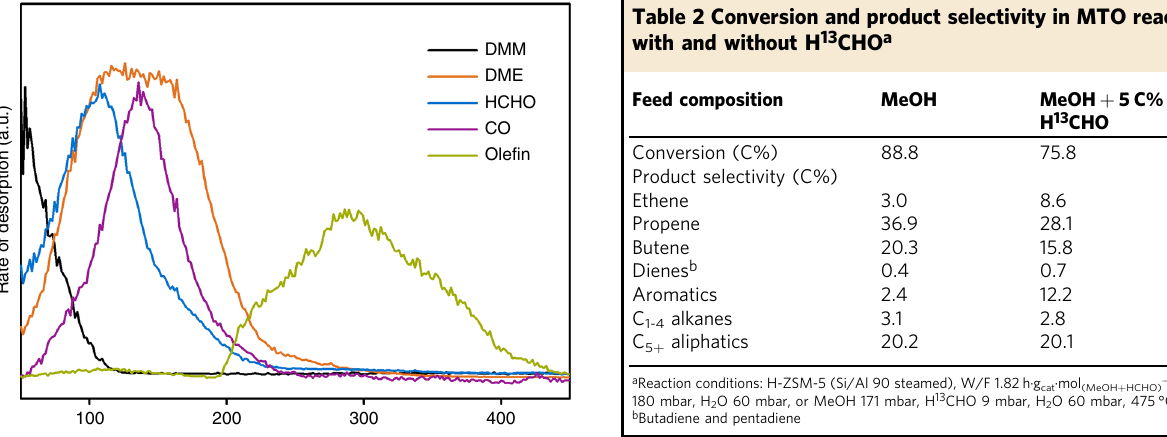
Table 2 Conversion and product selectivity in MTO reaction